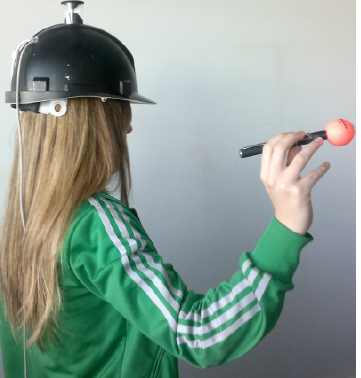
Figure 10. Wearable flexible structured light system with light emitter in